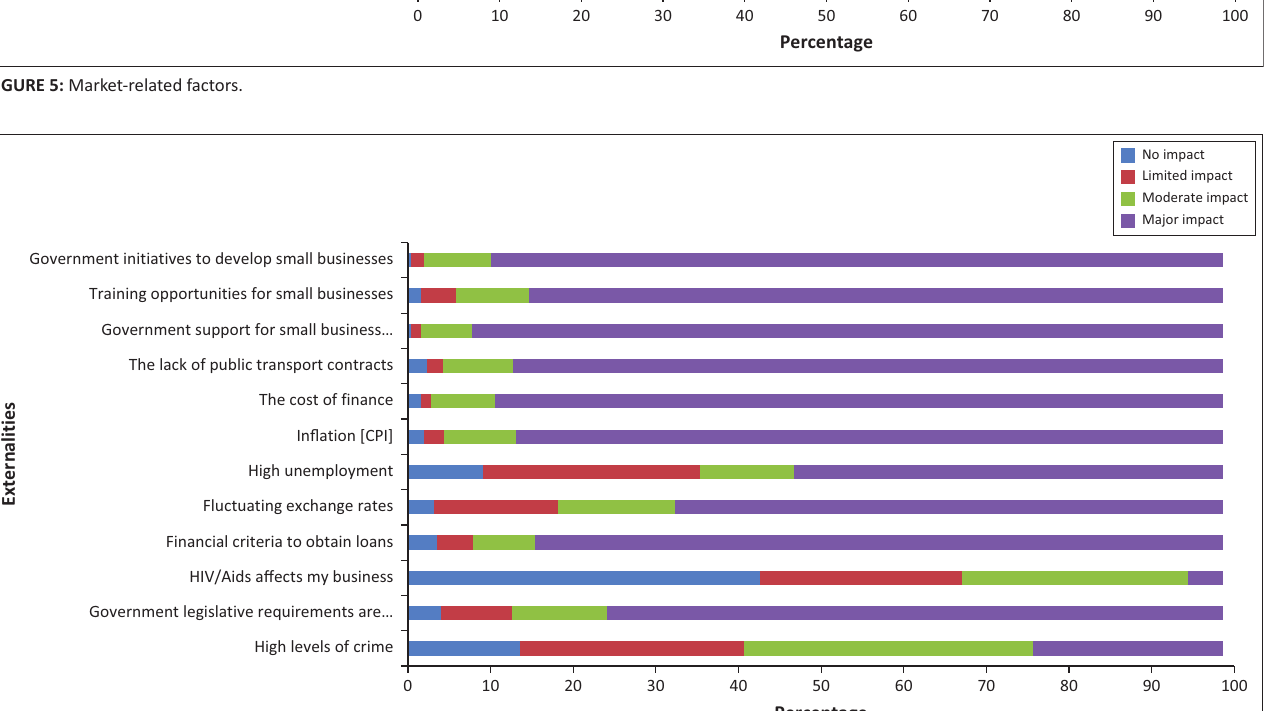
TABLE 3: Factor loadings after rotation: Externalities impacting small-bus operators. Factor 1: Financial aspects of managing an SBO